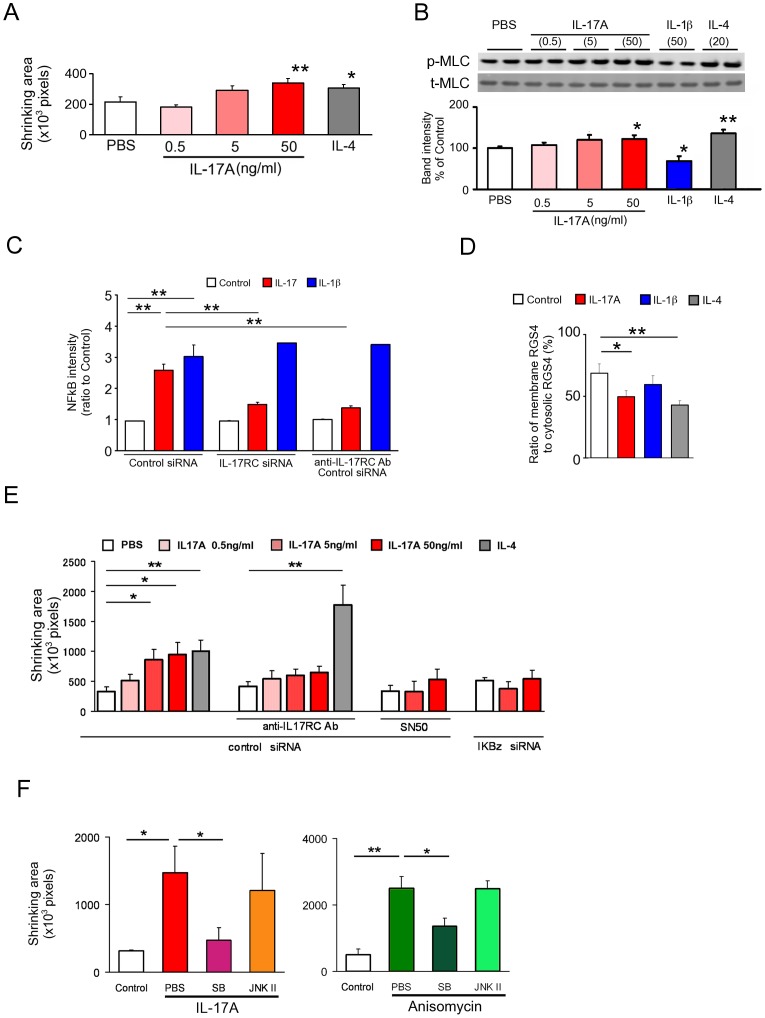
IL-17A-induced hypercontractility and its signal transduction in cultured human colonic SMCs.(A) Contractility assay of IL-17A-treated human SMCs. SMCs were cultured with IL-17A and IL-4 for 5 days and contractility was evaluated as described in Figure? 6A. (B) Immunoblot analysis of p-MLC and quantitation of band intensity in samples of colonic SMCs treated with or without IL-17A, IL-1β or IL-4 (n = 6). The cells were treated with 10−11 M CCh for 3 min. The ratio of p-MLC to total MLC was calculated as described in Materials and Methods and normalized to untreated samples. N refers to the number of experiments. Upper panels are representative images. (C) Relative intensity of NFκB p65 immunosignal accumulated in the nucleus was measured in cultured colonic SMCs after 30 min treatment with PBS, IL-17A or IL-1β in the absence or presence of anti-IL-17RC antibody or siRNAs to control and IL-17RC. (D) The effect of IL-17A and IL-1β on RGS 4 activity in human SMCs on day 4 was assessed (n = 4). RGS4 activity was evaluated as described in Materials and Methods. (E) Effect of anti-IL-17RC antibody, SN50 and IκBζ siRNA on IL-17A-induced contractility in human SMCs. Contractility was measured on day 4 (n = 3–6) as described in Fig.6A. (F) The effects of MAPK inhibitors on IL-17A- and anisomycin-induced hypercontractility on day 4 (n = 3–6). The left and right panels show the effects MAPK inhibitors on IL-17A-, and anisomycin-induced contractility, respectively. Contractility was measured as described in Fig. 6A (n = 3). Numerical data represent means ± s.e.m. *P<0.05, **P<0.01, Student's t-test under the closed testing procedure for multiple comparison (A–F).